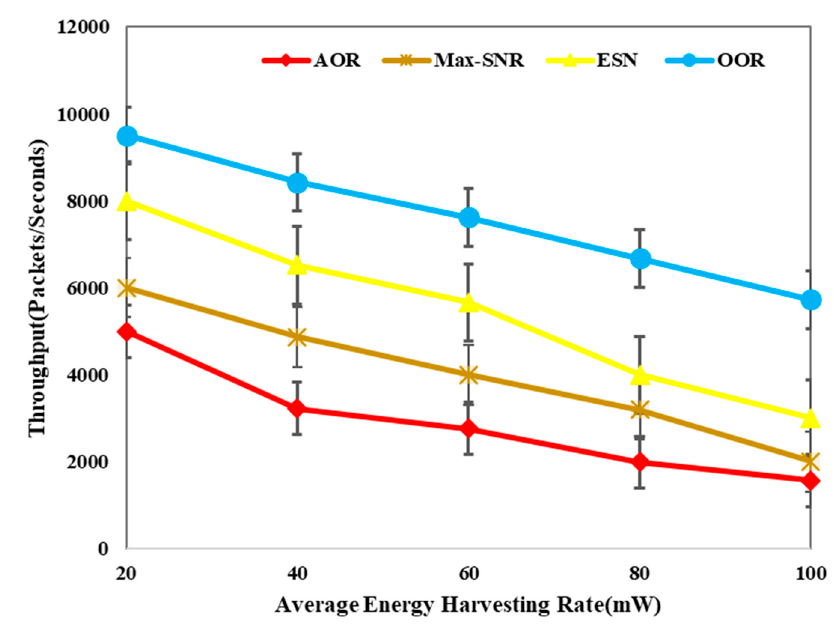
Figure 14. Throughput comparison with varying average energy harvesting rates. Table 6. Descriptive observations of OOR performance in terms of throughput (second scenario).